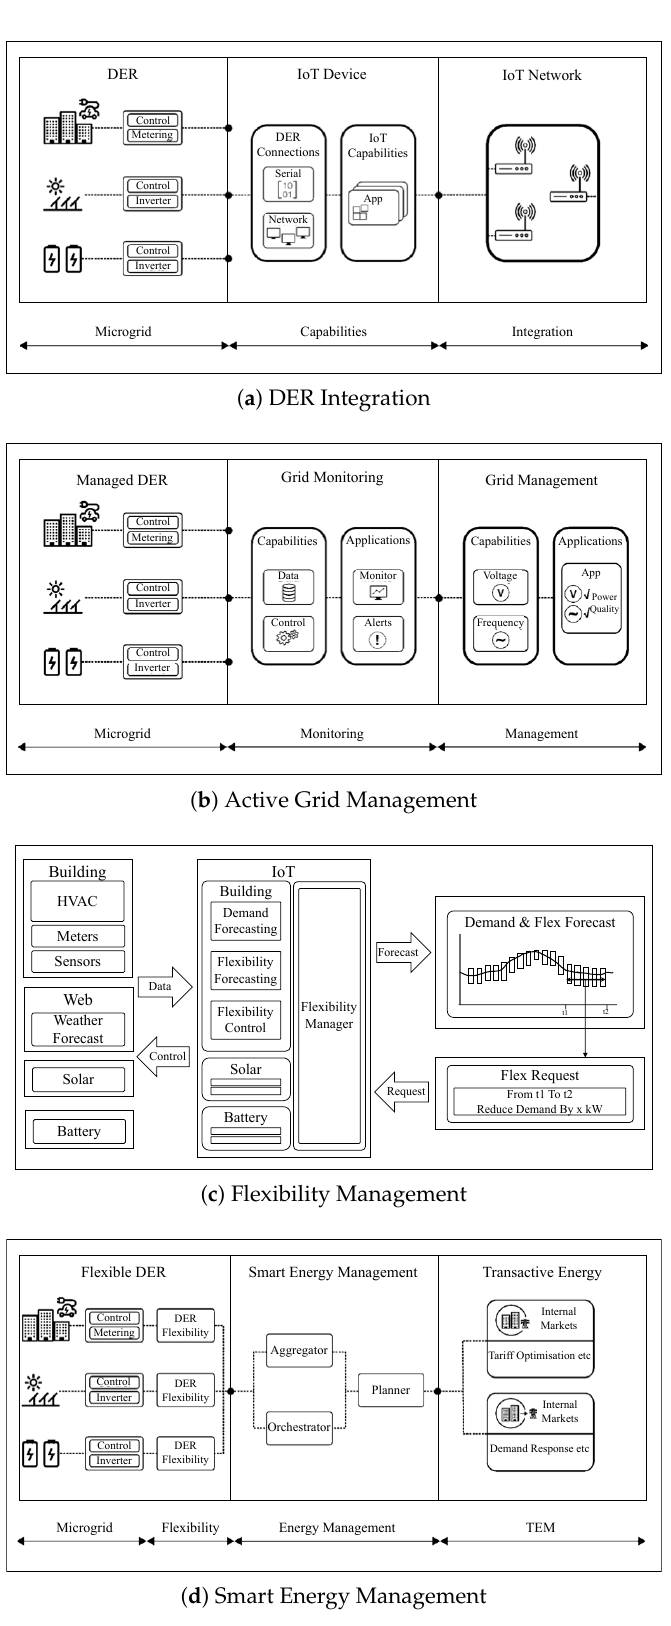
Figure 5. Enablement layers for Transactive energy